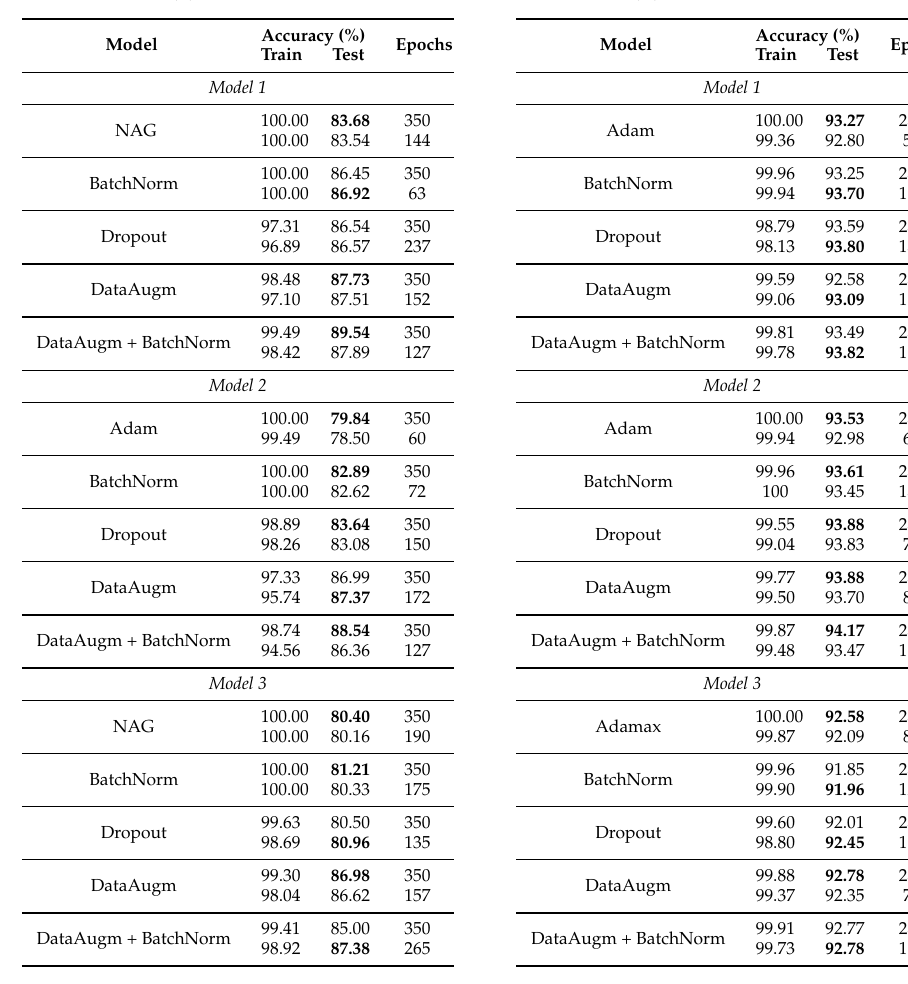
Table 10. Comparison of the accuracy results obtained with and without Early Stopping.